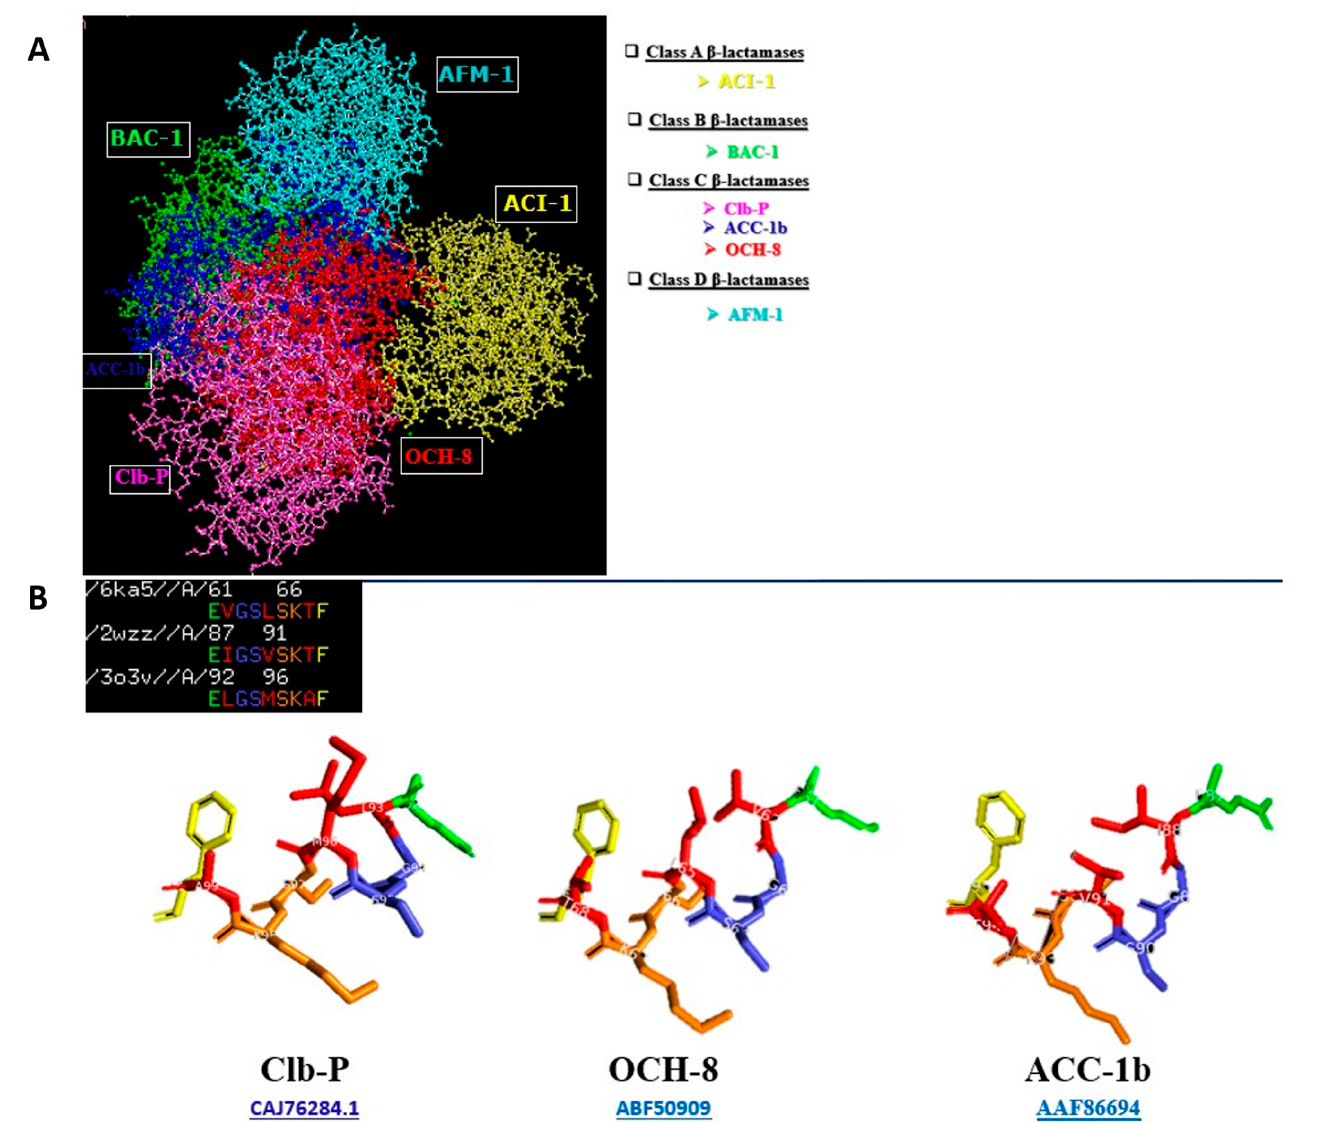
Figure 3. ( A ) A molecular model of the ClbP protein exhibiting a protein structure similarity with class C β -lactamase proteins. ( B ) 3D structure of the complete motif “SxxK” created using the PyMOL 1.8.6.0 software shown in the ClbP enzyme and in the other class C β -lactamases. Moreover, the chemical cleavage site of the β -lactamase and the ClbP enzyme are similar; both enzymes cut the bond between nitrogen and carbon atoms (Figure